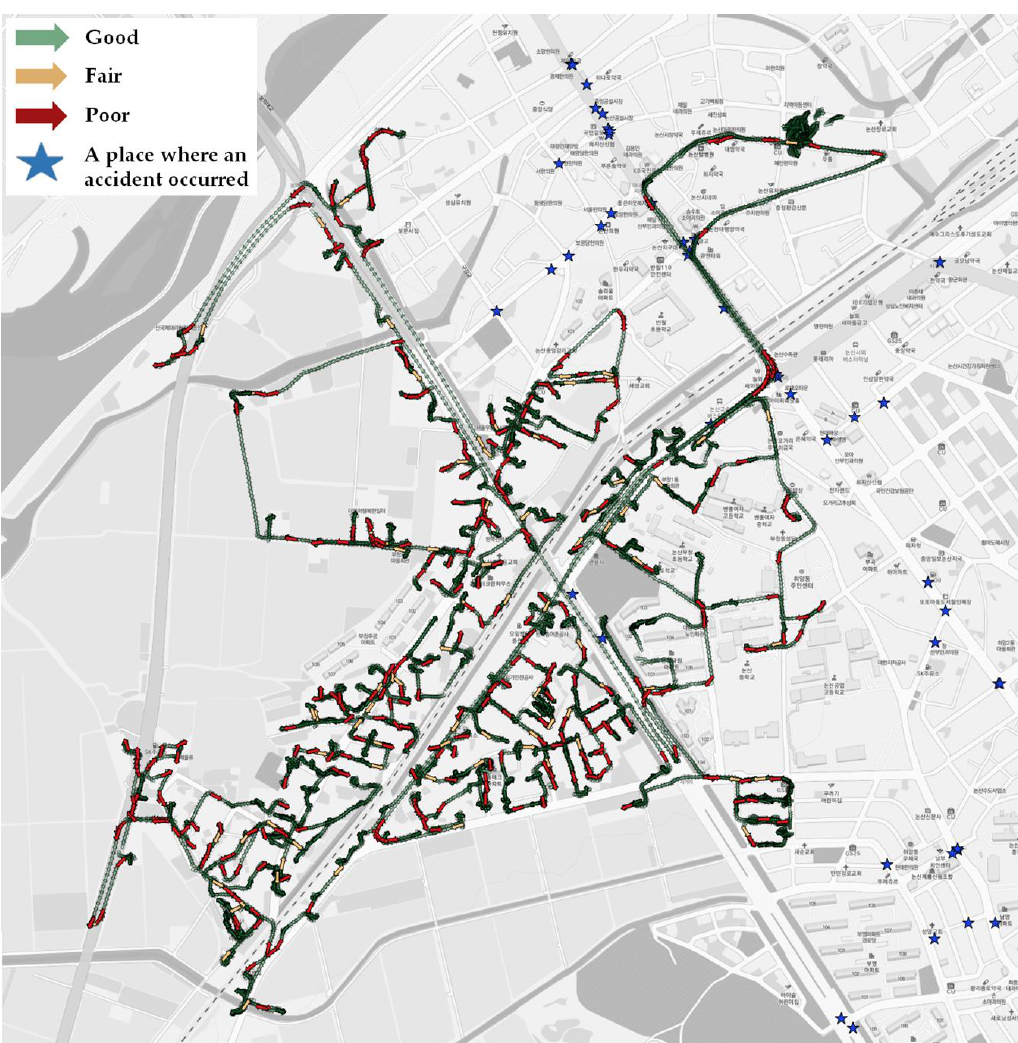
Figure 1. Distribution of a postal motorcyclist’s safety index plotted on a work route and locations of accidents during 2014–16. Safety performance is represented using green for “Good”, yellow for “Fair”, and red for “Poor”. Accident locations are indicated by blue colored stars.